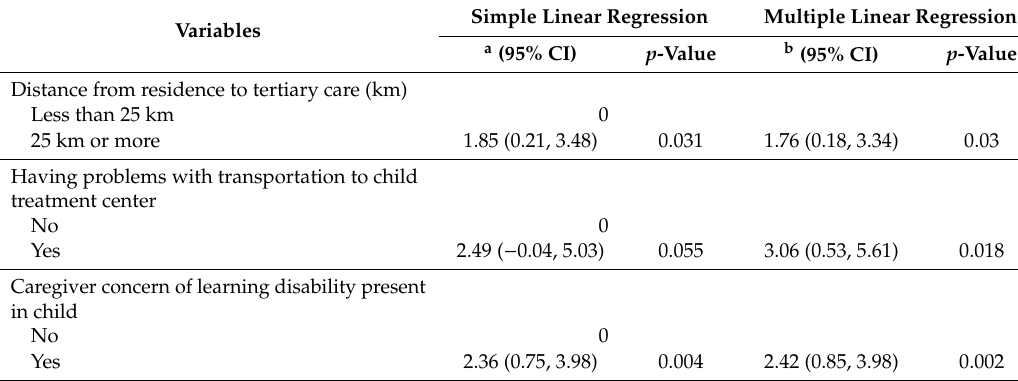
Table 5. Predictors of perceived stress among caregivers with ASD children ( n = 227). Simple Linear Regression Multiple Linear Variables